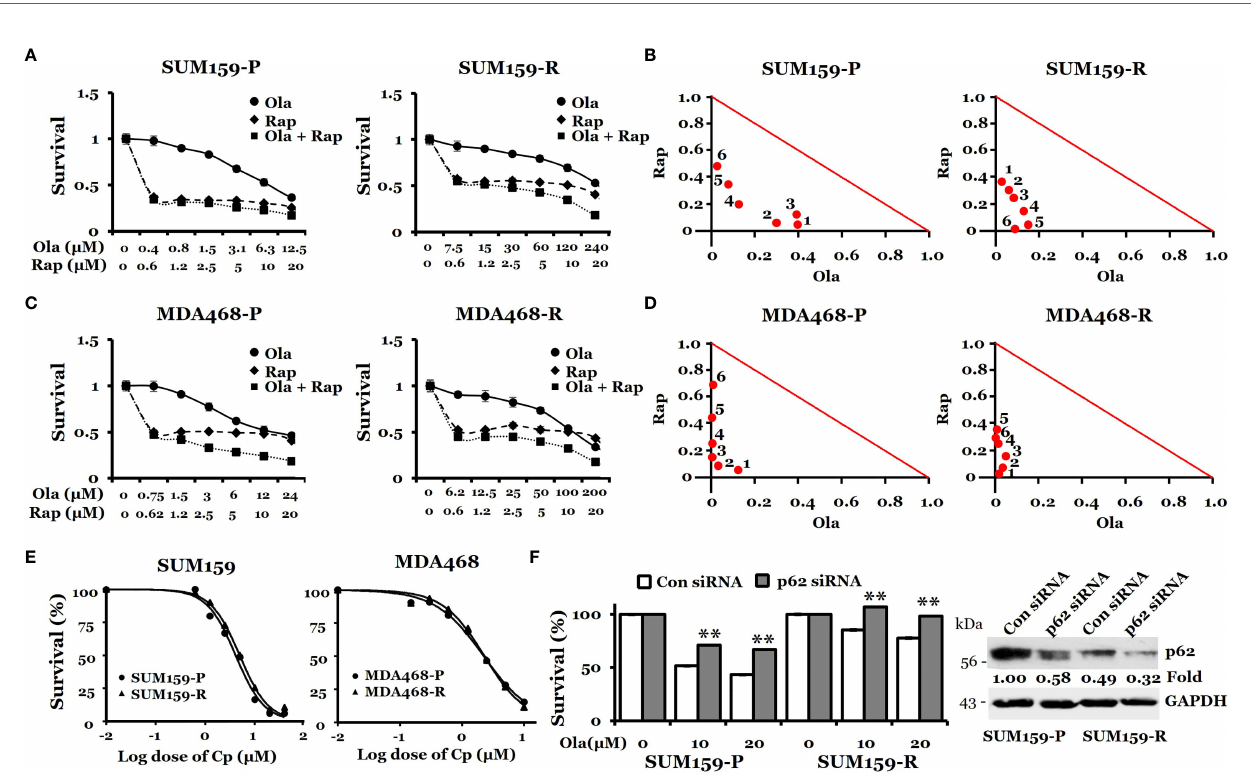
FIGURE 6 | Effects of rapamycin plus olaparib or cisplatin alone on the growth of olaparib-resistant TNBC cells. (A, C) , Synergistic effects of rapamycin and olaparib treatment on the growth of SUM159-P and SUM159-R cells (A) and MDA468-P and MDA468-R cells (C) . Cells were treated with indicated drug combination for 72 hrs. (B, D) , Normalized isobologram for SUM159-P and SUM159-R cells (B) and MDA468-P and MDA468-R cells (D) . (E) Sensitivity of olaparib-resistant cells to cisplatin in parental and olaparib resistant SUM159 cells (left) and MDA468 cells (right). Cell viability was measured using MTT assay after treatment with varying concentrations of cisplatin for 72 hrs. All experiments were performed in triplicates. P, parental; R, resistant; Ola, olaparib; Cp, cisplatin; Rap, rapamycin and con, control. (F) Effect of p62 knockdown on olaparib sensitivity in SUM159 cells. SUM159-P and SUM159-R cells were transfected with p62 siRNA or non-target siRNA (Con siRNA). MTT was performed to assess olaparib sensitivity (left panel), and the level of p62 knockdown was evaluated by western blotting (right panel). Student ’ s t-test: ** p <